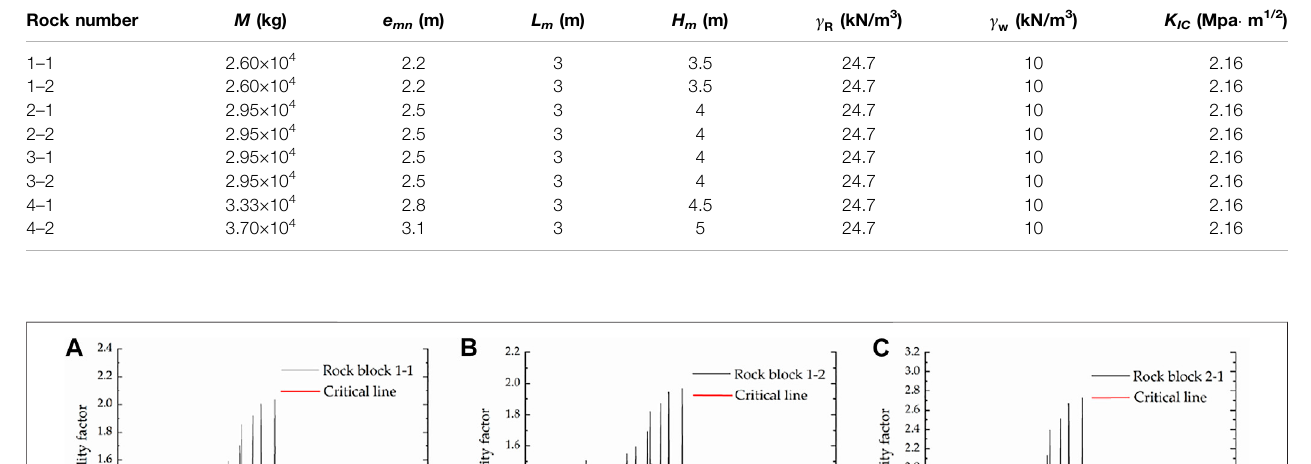
Frontiers in Earth Science |